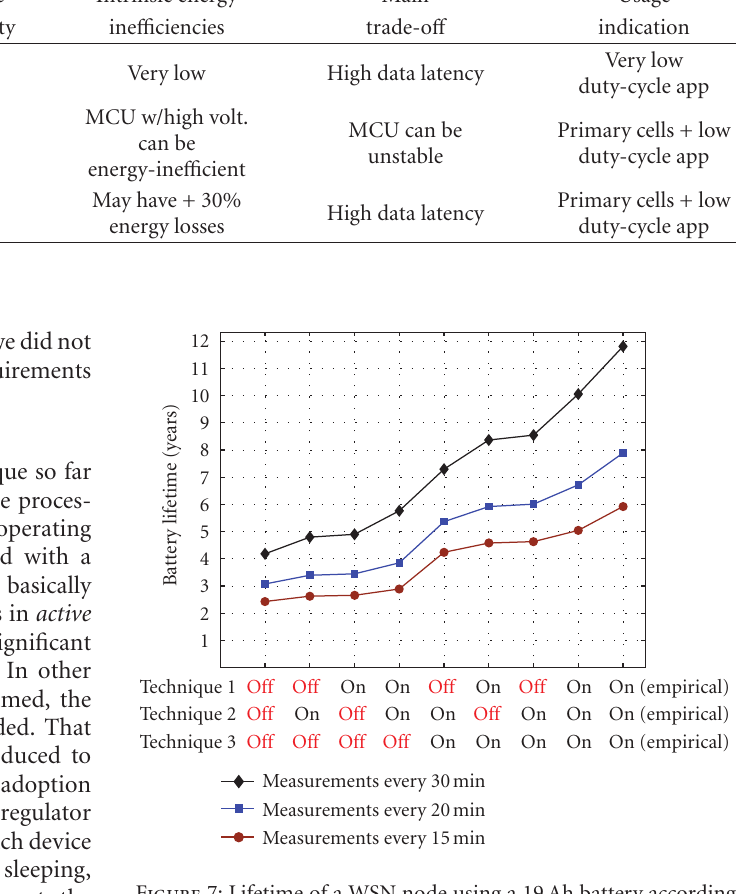
Figure 7: Lifetime of a WSN node using a 19Ah battery according to di ff erent power